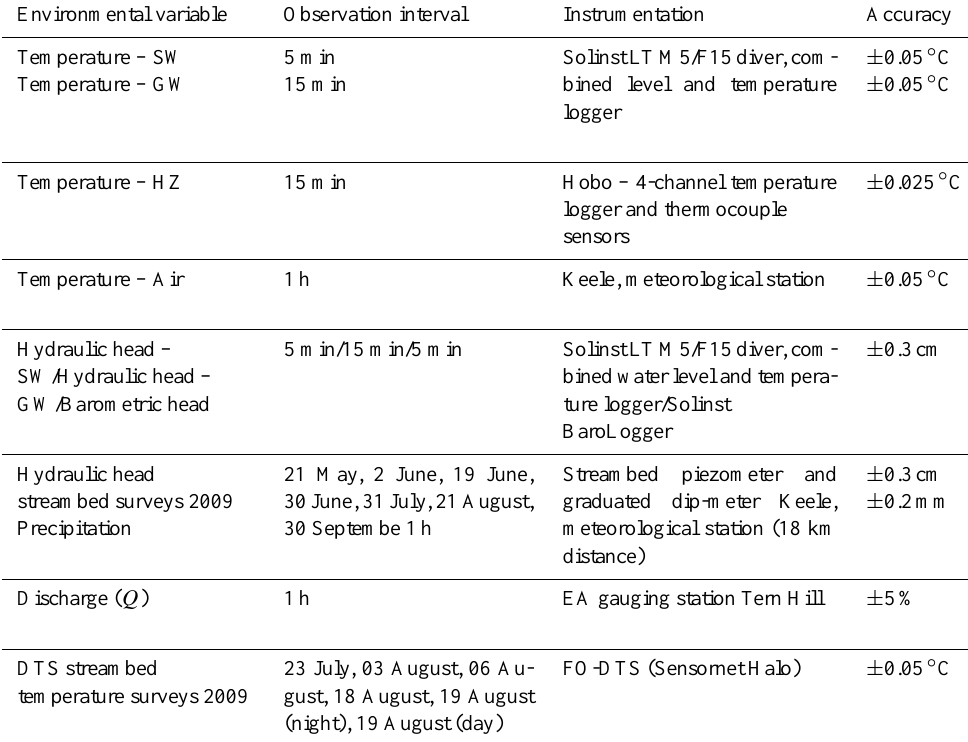
Table 1. Spatial and temporal resolution of environmental parameters monitored during the 2009 sampling